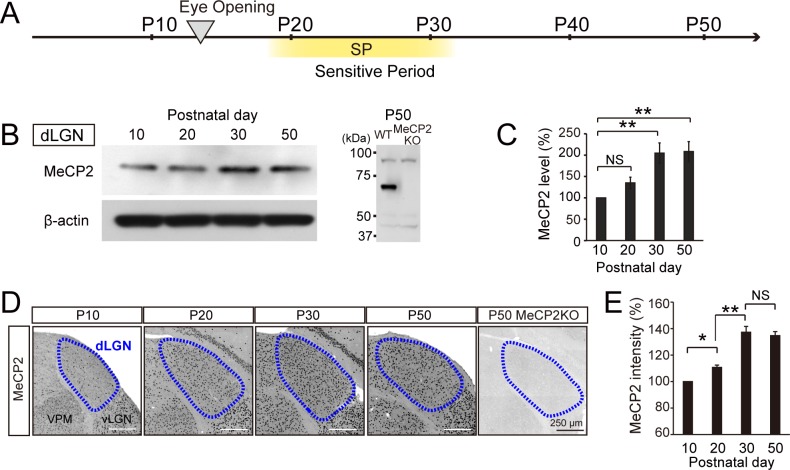
MeCP2 expression in the dLGN is elevated during the sensitive period of the visual system.(A) Developmental events involving the visual system. Reverse triangle: eye opening at P12–P14; SP, sensitive period. (B) Western blots for MeCP2 using dLGN lysate of wild-type (WT) mice obtained at P10, P20, P30, and P50 (left) or whole-brain lysate of MeCP2 KO mice (right) obtained at P50. (C) Quantification of MeCP2 expression level. The MeCP2 level at P10 was defined by 100%. **, P < 0.01. Statistical analysis for each developmental period was performed using the Steel-Dwass test. NS, not significant. n = 6 sample for 18 animals. (D) MeCP2 immunohistochemical staining in dLGN of WT mice at P10, P20, P30, and P50, and MeCP2 KO mice at P50. Blue dotted lines, dLGN. VPM: ventral posteromedial nucleus. vLGN: ventral lateral geniculate nucleus. Scale bar, 250 μm. (E) Quantification of MeCP2 fluorescence intensity in dLGN. MeCP2 intensity at P10 was defined as 100%. P20: 110.7% ± 1.7% vs. P30: 137.3% ± 4.3%, **P < 0.01. Statistical analysis for each developmental period was performed using the Steel-Dwass test. NS, not significant. P10: n = 24 sections for 7mice, P20: n = 26 sections for 8 mice, P30: n = 22 sections for 7 mice, P50: n = 36 sections for 10 mice.